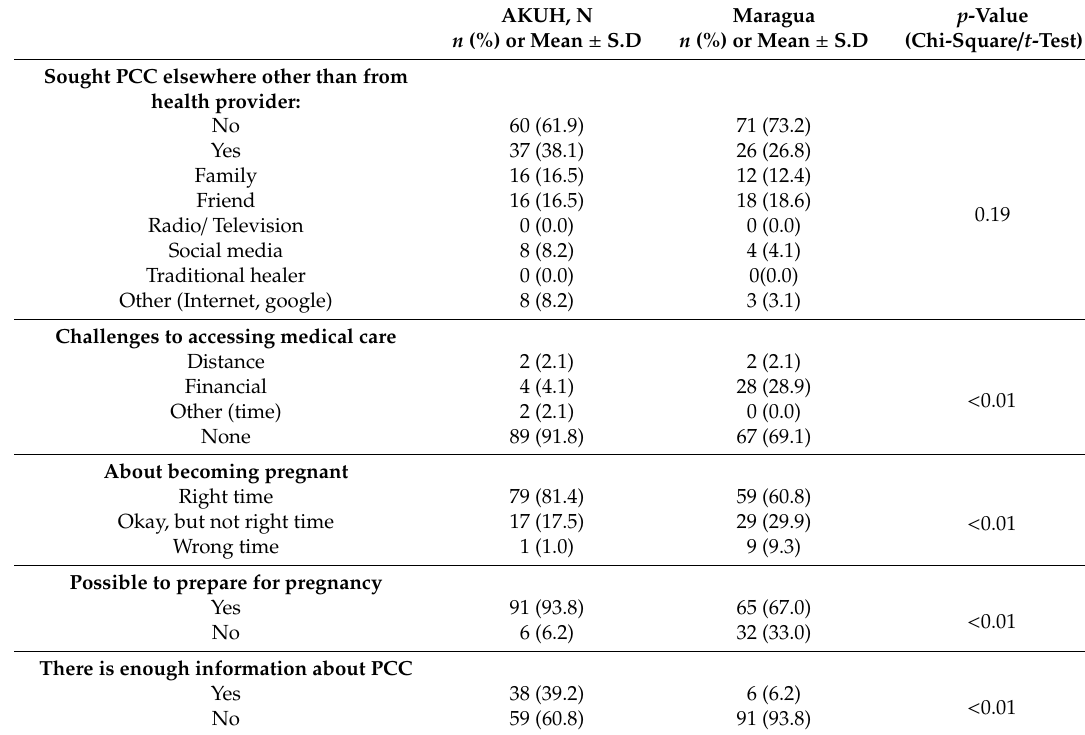
Table 3. PCC utilization.